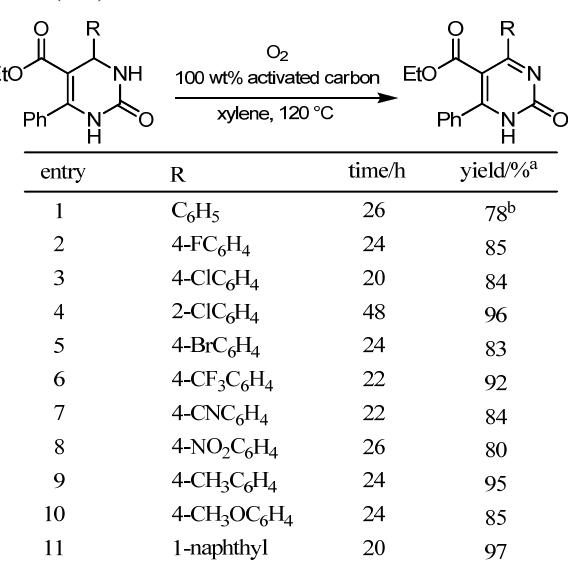
Table 6. Oxidative conversion of functionalized 3,4-dihydropyrimidin-2( 1H )-ones into the corresponding pyrimidin-2( 1H )-ones.